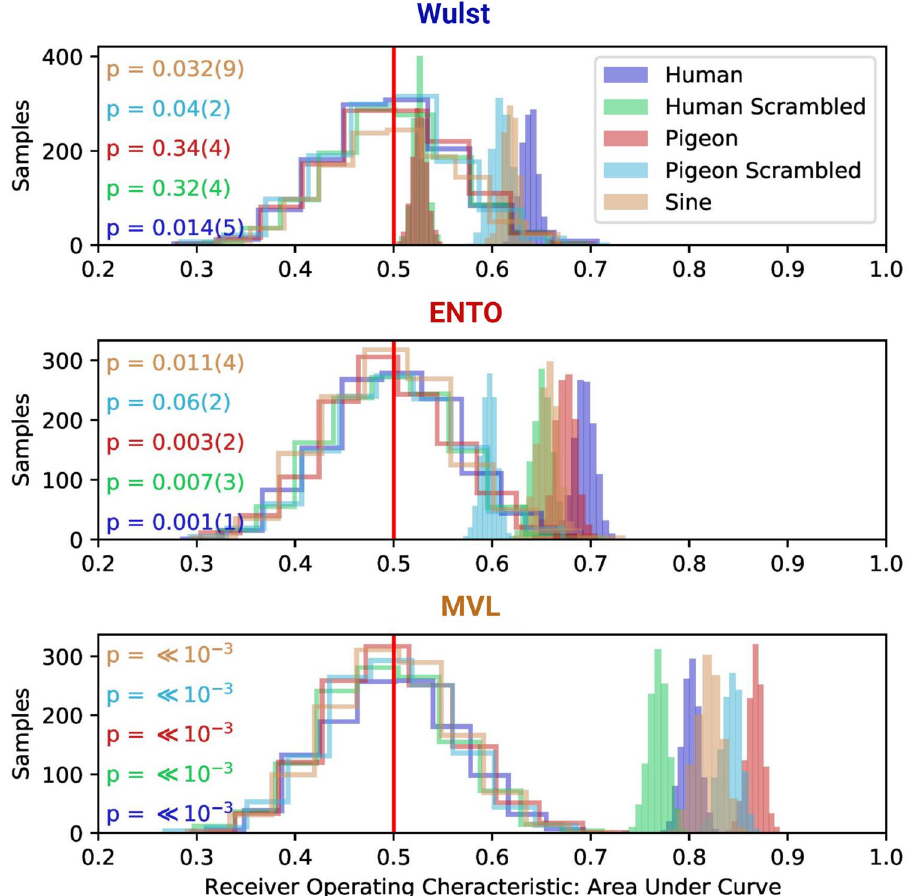
Figure 7. LDA performance shows that the MVL population response encodes stimulus feature information. The un-filled distributions show the performance of the LDA trained on randomly labelled data, which contain "no information" for the permutation significance test. The shaded distributions show the performance of the correctly labelled data. p-values (and their error) are shown to the left for each stimulus grouping (color coded on the left). The p-value for each stimulus grouping is derived from how far away from the "no information" distribution of samples that the correctly labelled performance